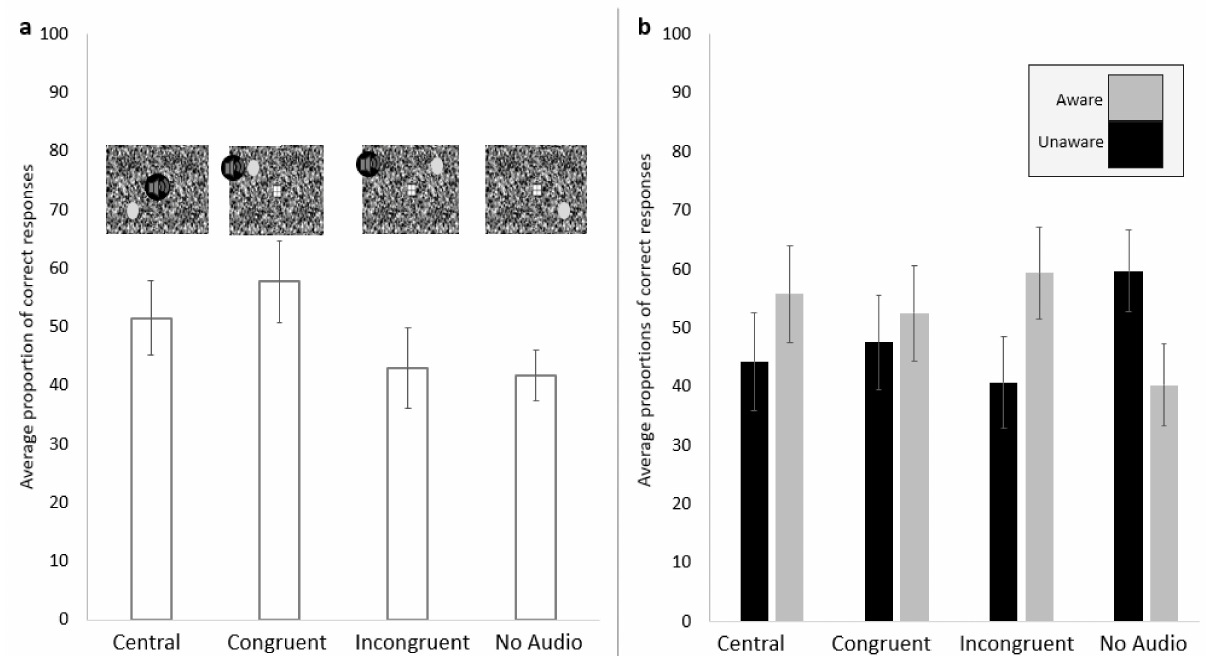
Figure 4. The proportion of correct trials (aware and unaware) for each condition ( a ) and the proportion of aware (grey) and unaware (black) of all the correct trials ( b